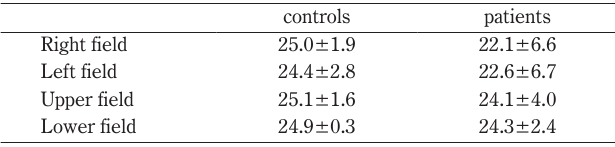
Table 4 Scores on the active motion detection